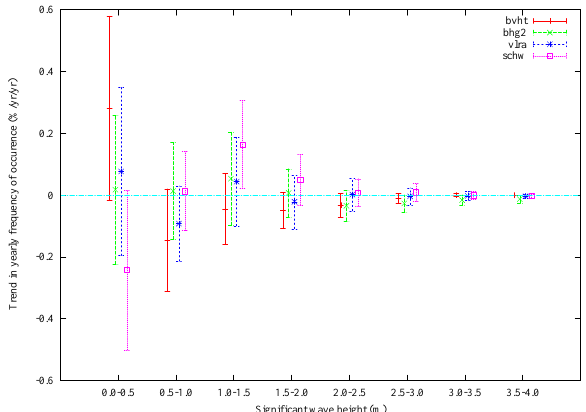
Figure 5: Trend in the yearly frequency of occurrence for the difference significant wave heights. bvht: Bol van Heist; bhg2: Brouwershavensegat 2; vlra: Vlakte van de Raan; schw: Scheur West. The error bars give the 95% confidence interval.